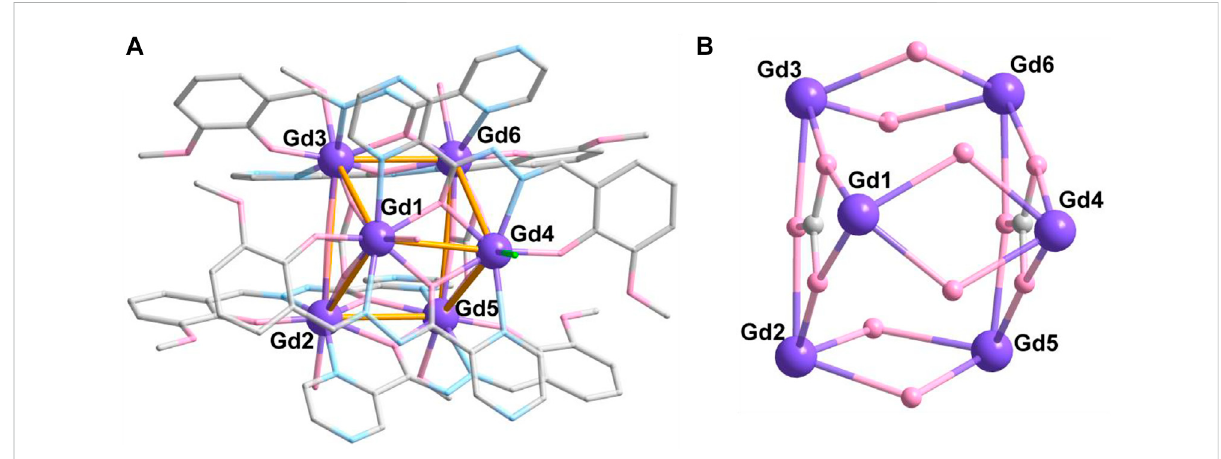
FIGURE 2 Crystal structure (A) and metallic core (B) of complex 2 . The hydrogen atoms are omitted for clarity. Color codes: Gd, purple; O, pink; N, blue; and C,